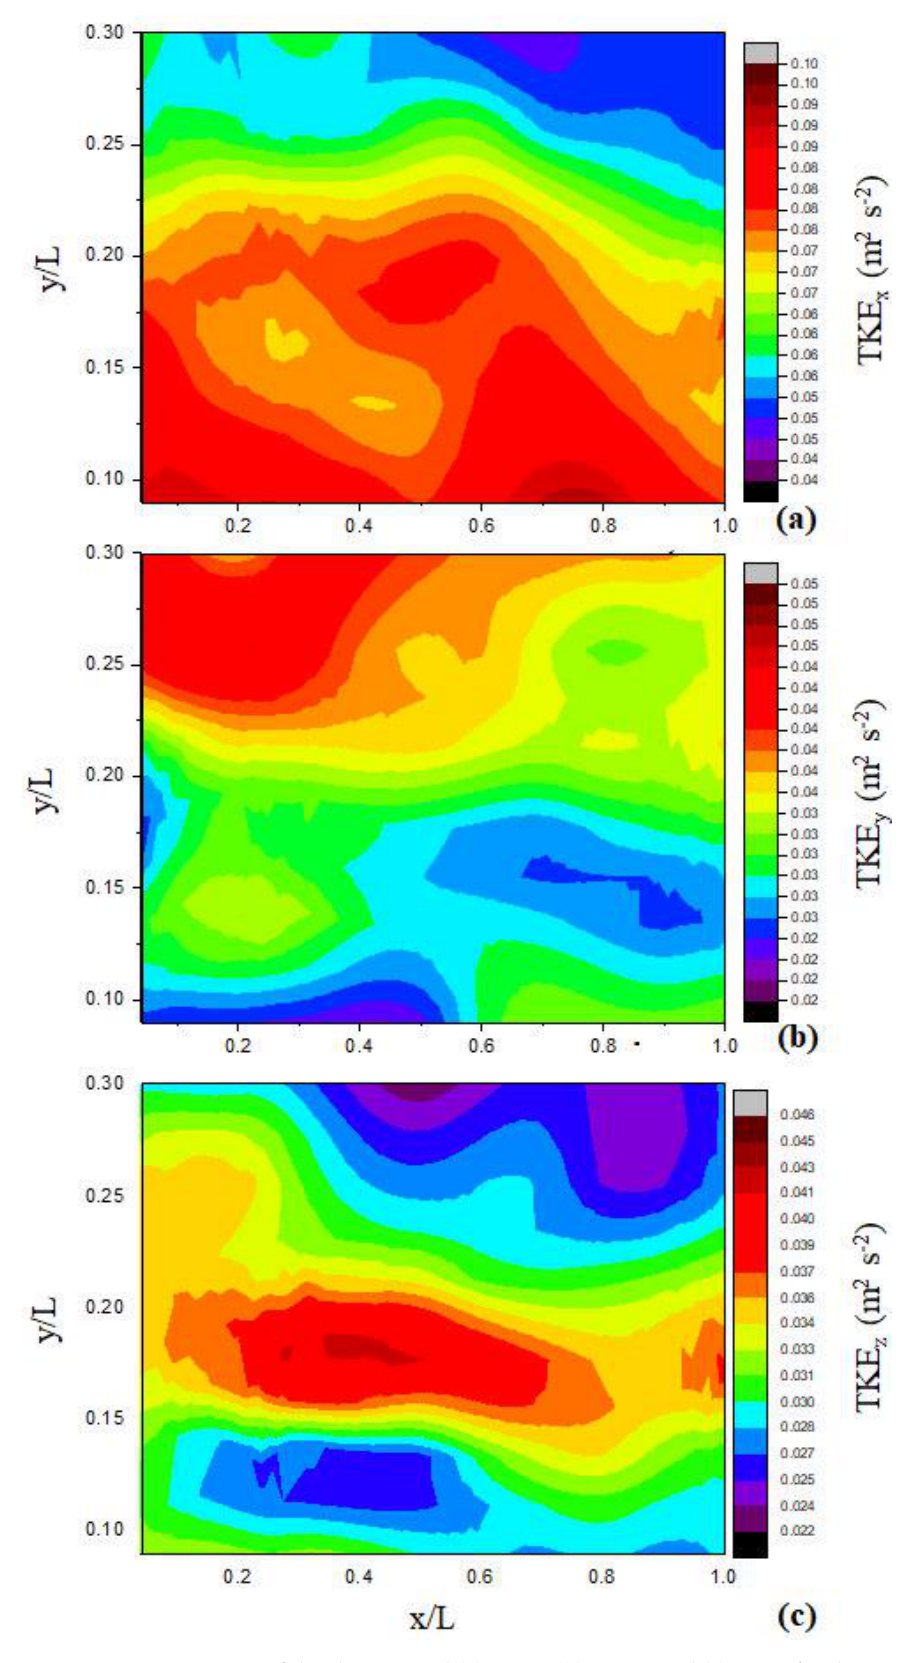
Figure 3. Contour maps of depth-averaged ( a ) TKE x , ( b ) TKE y , and ( c ) TKE z for the experimental run 1R (no sand bar emerging from the flume bed).